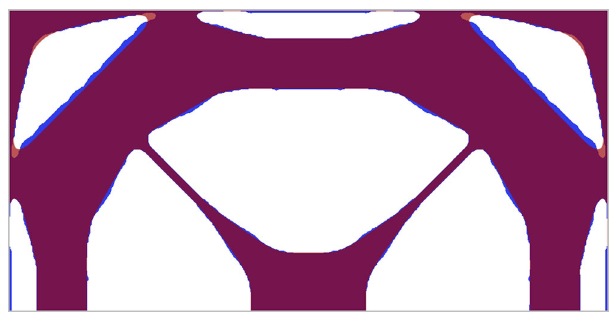
Fig. 6 Design post-processing. Comparison of the generated topology optimized design (blue) and the subsequent post-processed design (red) overlaid on top used in experiments for design